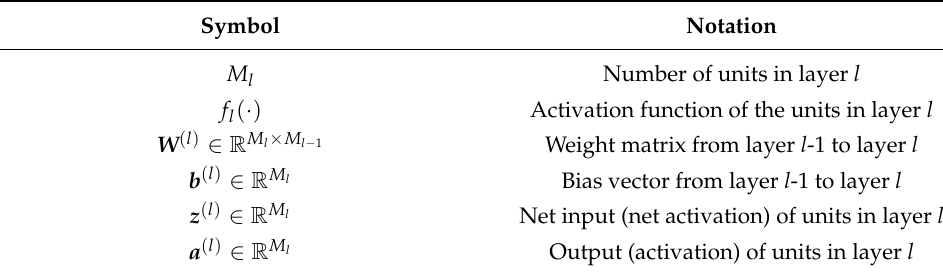
Table 2. Notation of the symbols in the